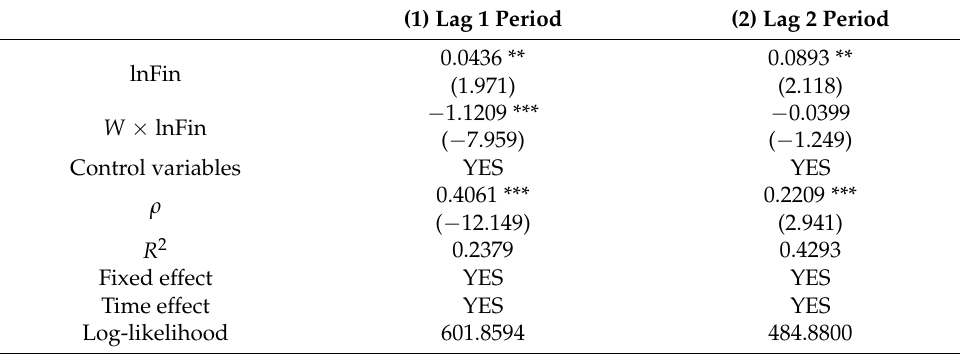
Table 12. The results of temporal heterogeneity